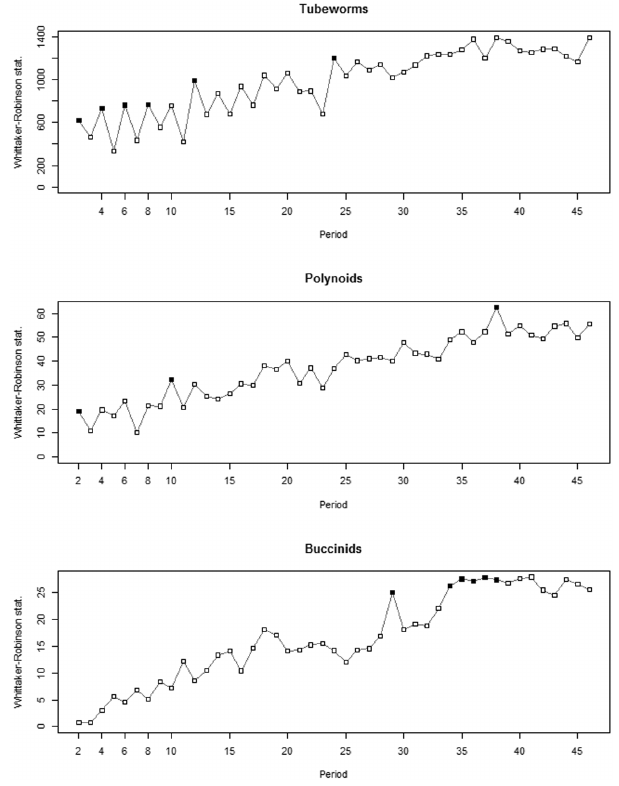
Figure A2. NEP faunal periodograms of 23 days featuring signifi- cant periodicities. Taxa presented are tubeworm, polynoid and buc- cinid densities with a 6h frequency for the MAR (1 period on x axis is equal to 6h); pycnogonids showed no significant periodici- ties and were not shown. Black squares indicate periods significant at the 5%